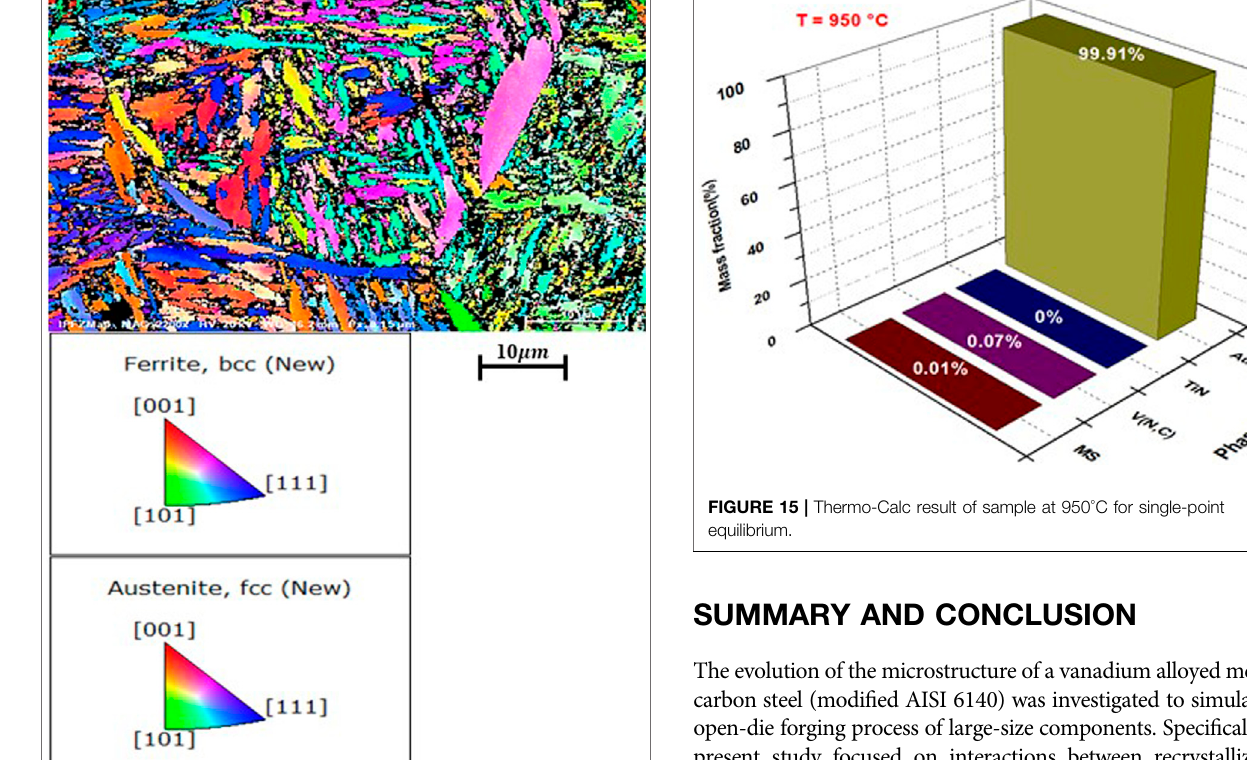
of deformed austenite ( Figure 13 ), which further con fi rms the mechanical testing results.